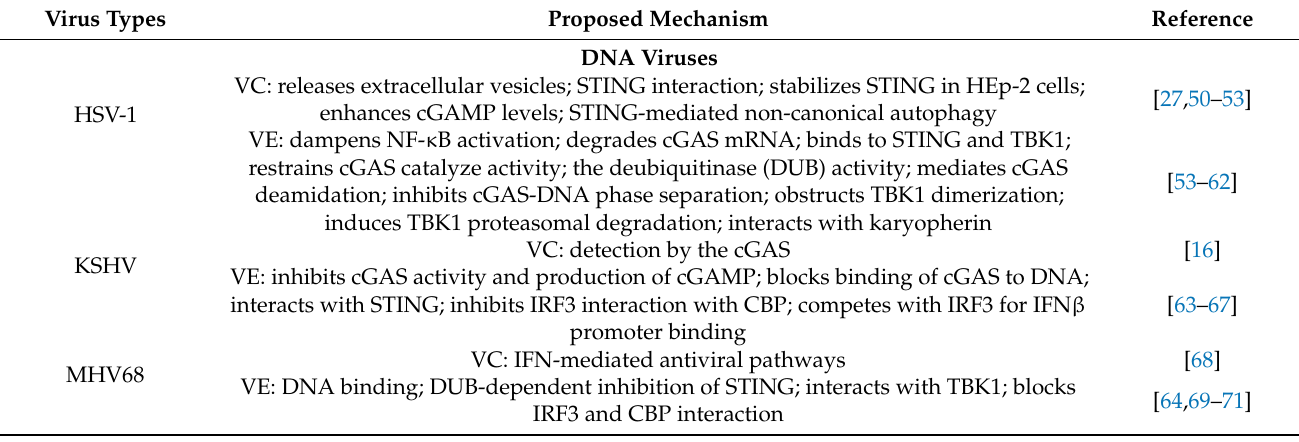
Table 1. Viral Regulators of the cGAS-STING Pathway and proposed mechanisms.